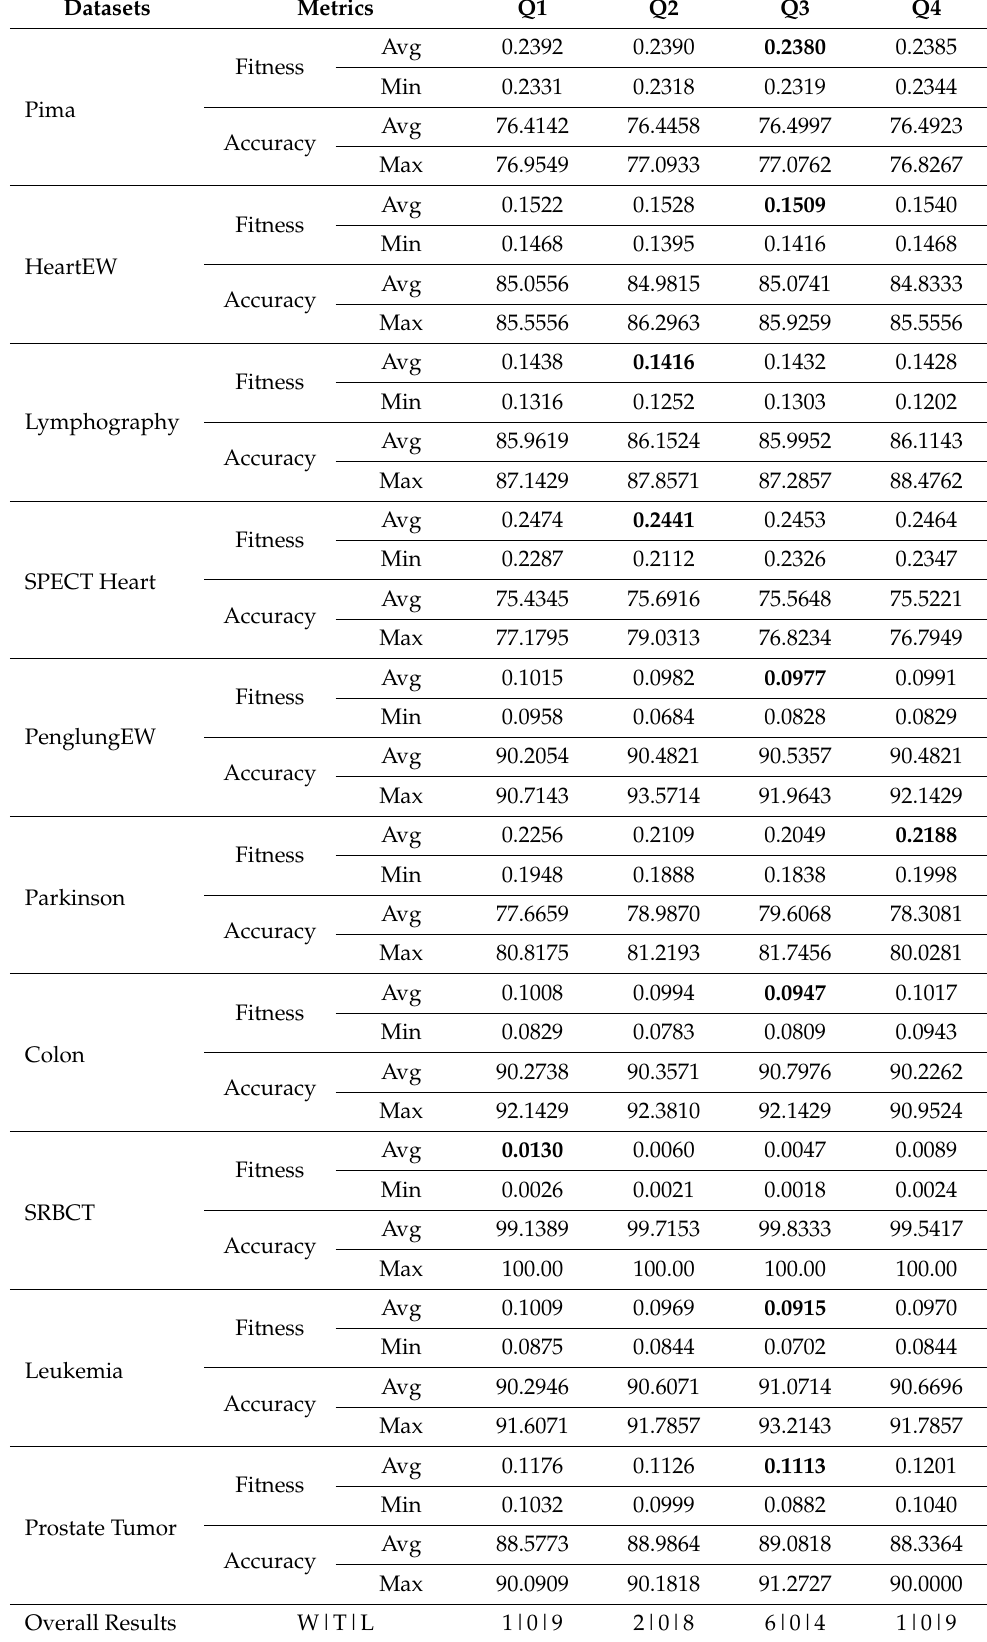
Table A5. The comparison results between different versions of